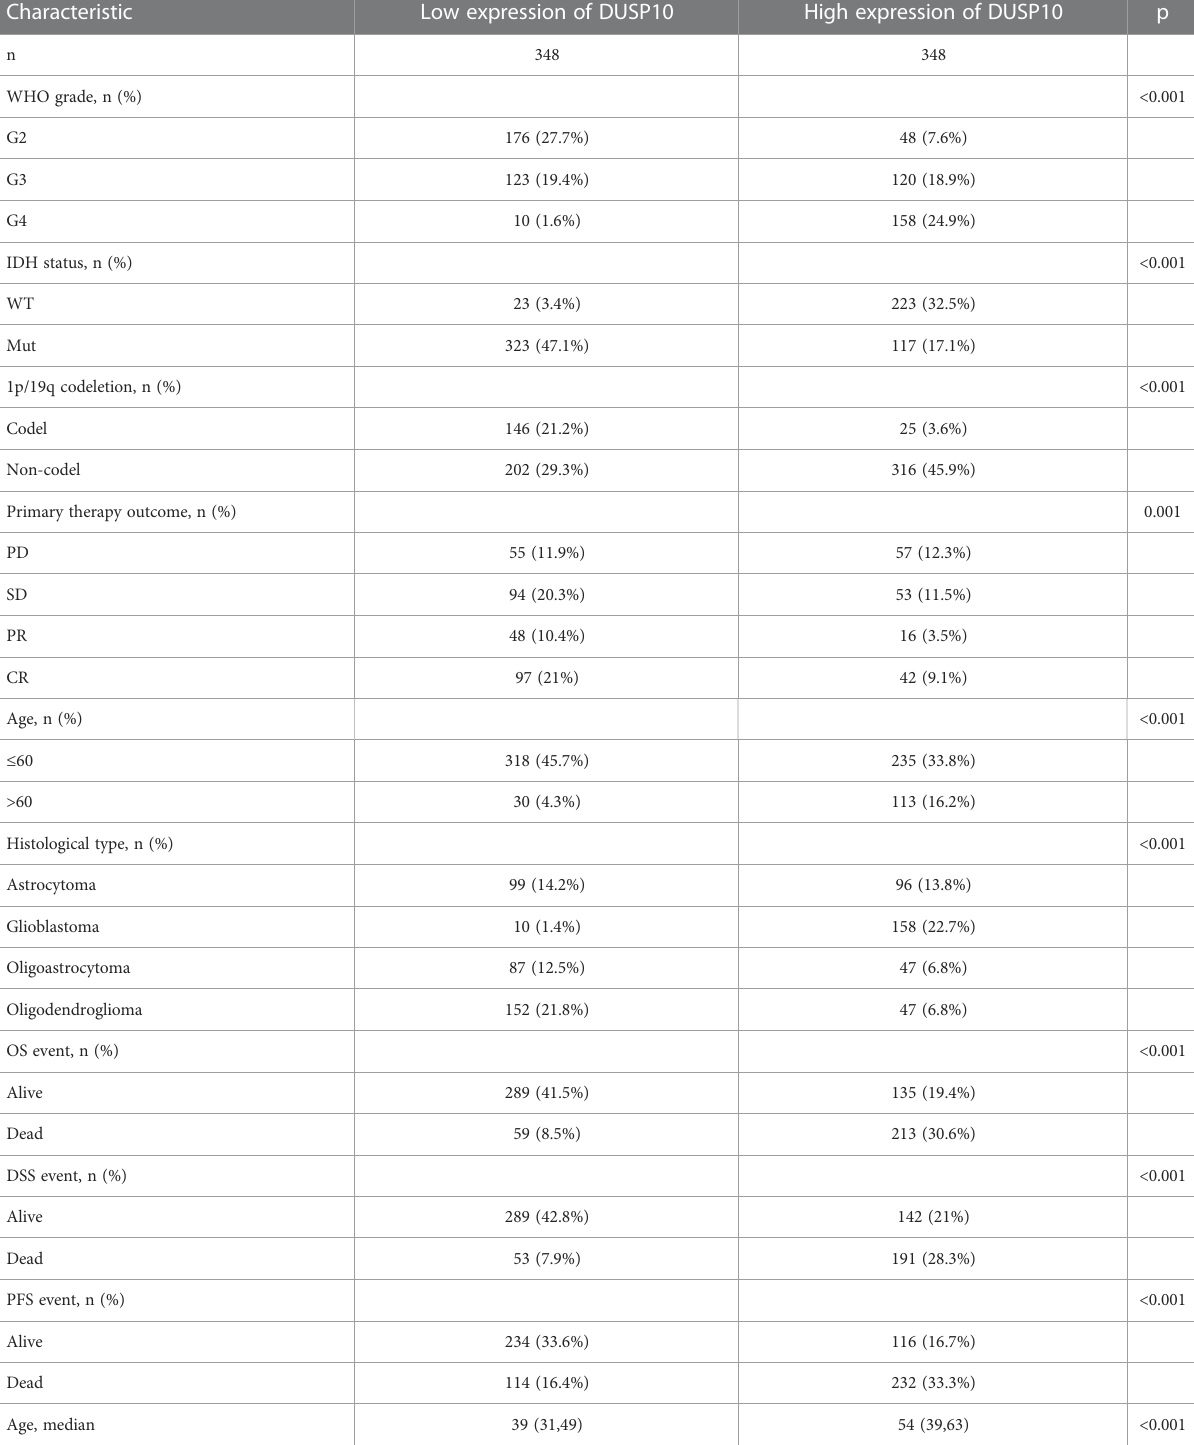
TABLE 1 Clinical characteristics of glioma patients in TCGA dataset according to DUSP10 expression.